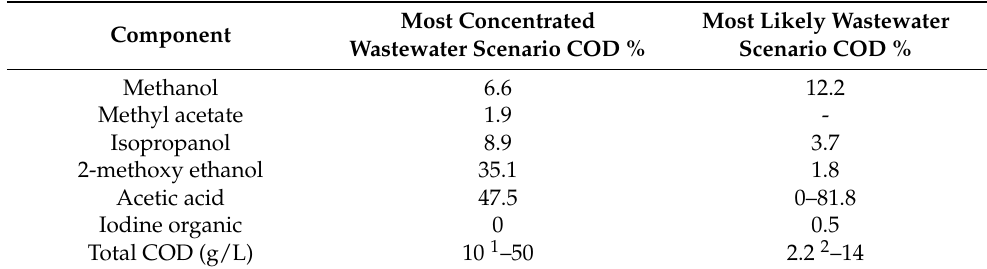
Table 1. Typical weight fraction and composition of the wastewater feed from the chemical industry on hourly and annual basis.